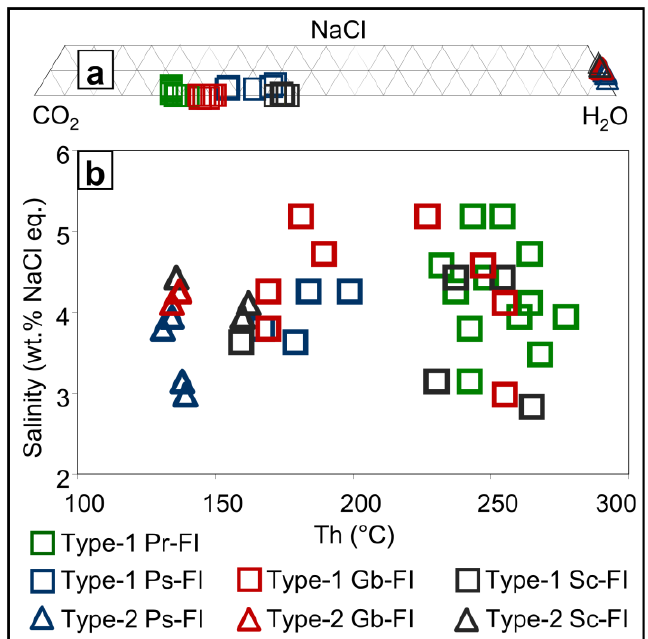
Figure 9. ( a ) A ternary diagram showing bulk CO 2 -H 2 O-NaCl ratios in all FI types and corresponding FI generations. ( b ) A plot of total homogenization temperature (T h(total) ) versus salinity.